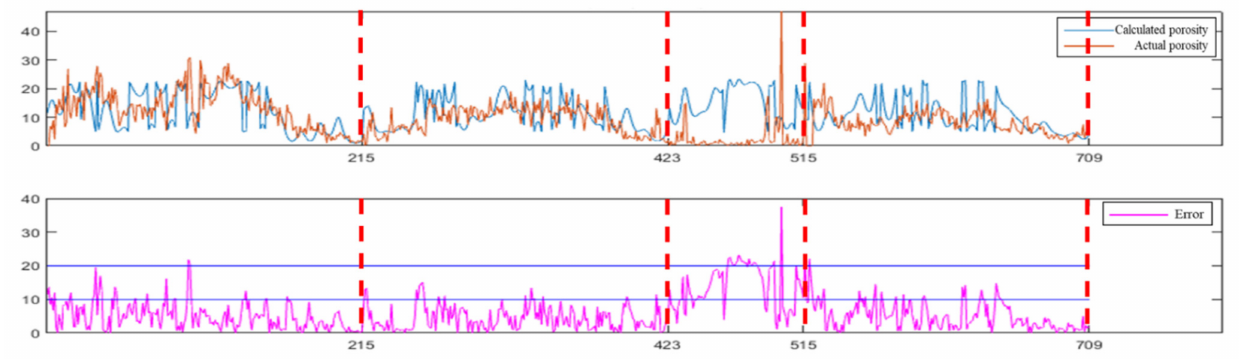
Figure 11. Comparison of the actual porosity of the four new wells with the porosity calculated by the deep neural networks based on the BP algorithm.